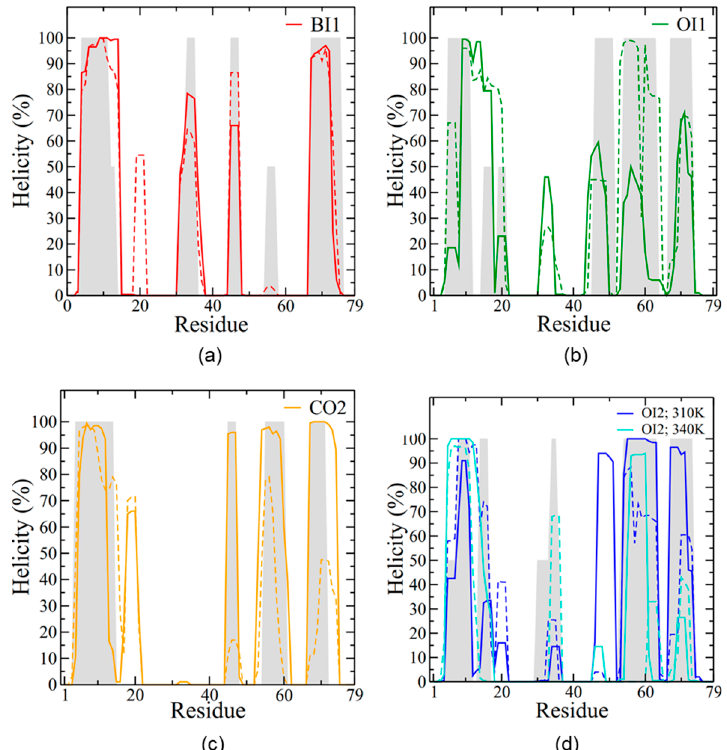
Figure 5. SP-B secondary structure during the last 0.5 μ s of simulation. The y -axis plots the percentage of time where a residue was in a helical conformation, with frames spaced 2 ns apart. The helicity per residue is reported for ( a ) BI1, ( b ) OI1, ( c ) CO2, and ( d ) OI2. Helicity is calculated for each subunit separately, with solid lines for the red subunit (depicted in Figure 2) and dashed lines for the blue subunit. In ( d ) dark blue represents the OI2 simulation run at a temperature of 310 K and light blue represents the system run at 340 K. The initial helicity is shown with grey shading, averaged for the two subunits.